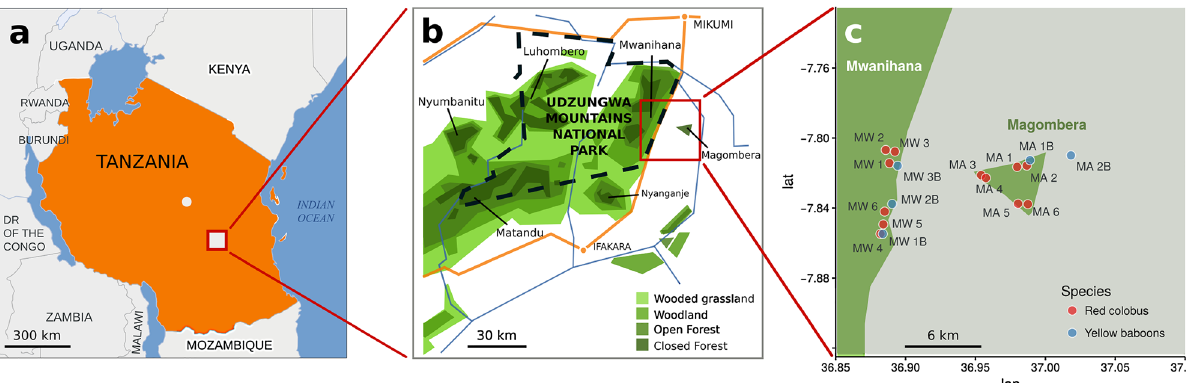
Figure 3. Map of the study site in the Udzungwa Mountains, Tanzania ( a ). Enlargement indicating the forested areas considered in this study: Mwanihana (protected forest) and Magombera (fragmented forest block) ( b ). Sample sites for Udzungwa red colobus (red circles: 12 social groups) and yellow baboons (blue circles: five social groups) ( c ). Dashed line in ( b ) indicates the border of the Udzungwa Mountains National Park. Original map reproduced with permission from 32